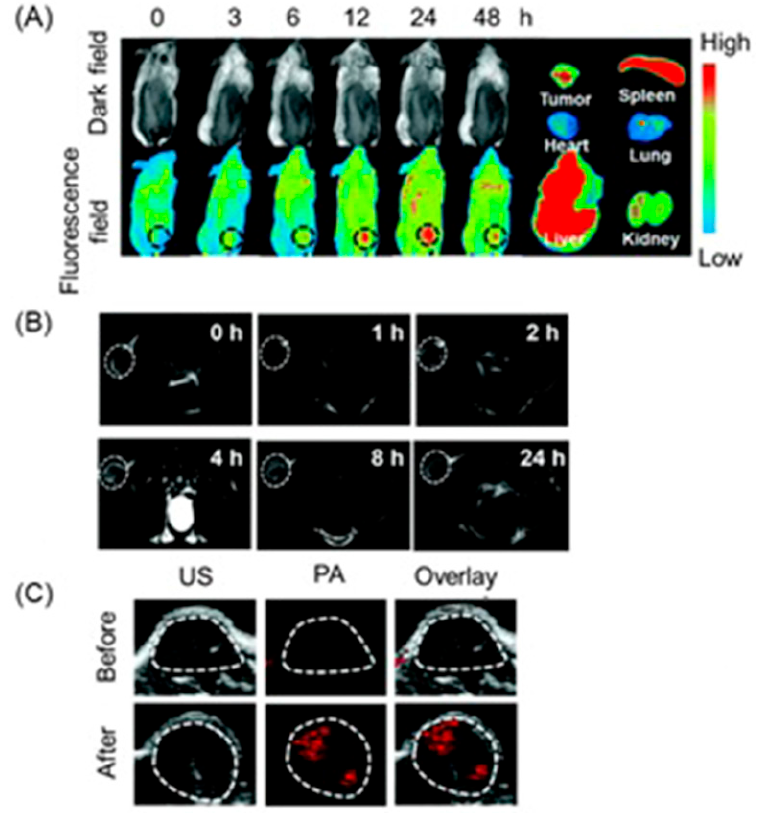
Figure 21. In vivo multimodal imaging. ( A ) Fluorescence images of mice bearing 4T1 tumors at 0, 3, 6, 12, 24, and 48 h after the injection of nanocomposite and fluorescence images of ex vivo organs and tumors excised at 24 h post-injection. ( B ) T 1 -weighted MRI of mice bearing 4T1 tumors at different time points after intravenous injection of nanocomposite, and ( C ) photoacoustic images in tumor region at 24 h before and after intravenous injection of nanocomposite. The white dashed lines enclose the tumor sites. Adapted with permission of the Royal Society of Chemistry, from A HMCuS@MnO 2 nanocomplex responsive to multiple tumor environmental clues for photoacoustic/fluorescence/magnetic resonance trimodal imaging-guided and enhanced photothermal/photodynamic therapy, Li, Q.; Ren, J.; Chen, Q.; Liu, W.; Xu, Z.; Cao, Y.; Kang, Y.; Xue, P. 12 , 23, 2020 ; permission conveyed through Copyright Clearance Center, Inc. [297].